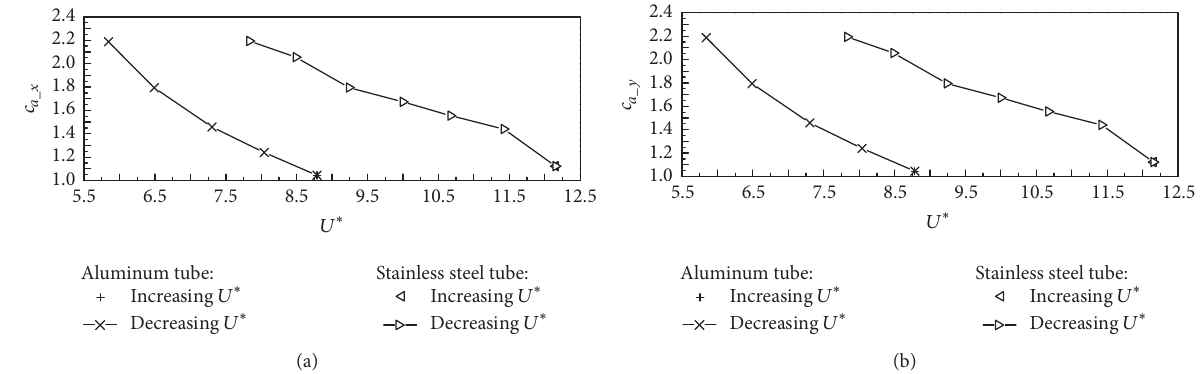
Figure 13: Added mass coefficients. (a) In-line direction; (b) transverse direction.